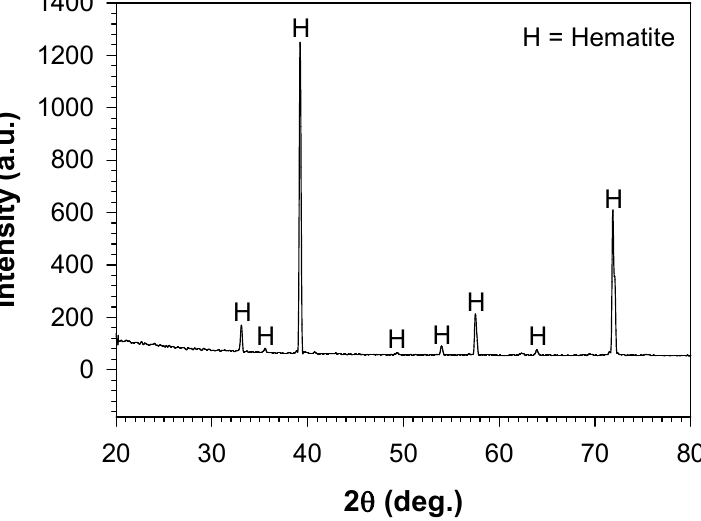
Figure 4. XRD pattern of the bare cast iron after cyclic oxidation at 850 °C in N 2 –12O 2 –10H for 14 cycles.